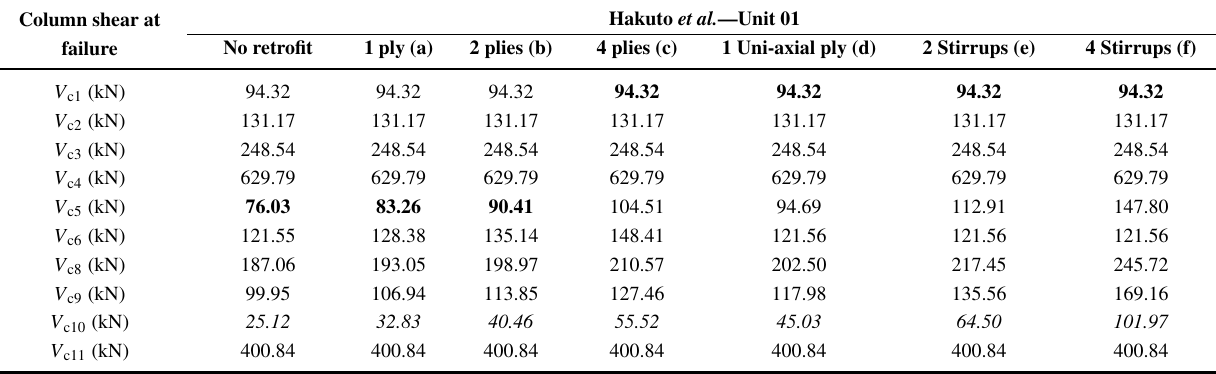
Table 7. General validation of model by means of comparison of experimental outcomes and simplified model